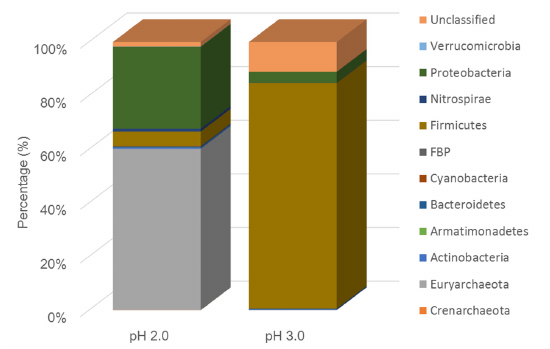
Figure 1. Phylum of the microbes after the anaerobic incubation at pH of 2.0 and 3.0, respectively. Table 3. Genus of the microbes and their percentage after the anaerobic incubation at pH of 2.0 and 3.0, respectively (percentage >2%). pH 2.0 pH 3.0 Ferroplasma : 61.8% Clostridiaceae : 67.9% Acidophilium : 23.0% Desulfosporosinus : 18.7% Clostridiaceae: 5.5% Alicyclobacillaceae : 8.6% Thermogymnomonas : 4.7%